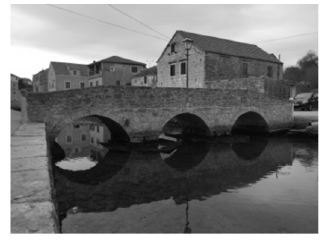
Figure 10. Goru č ica, Sinj (B7).